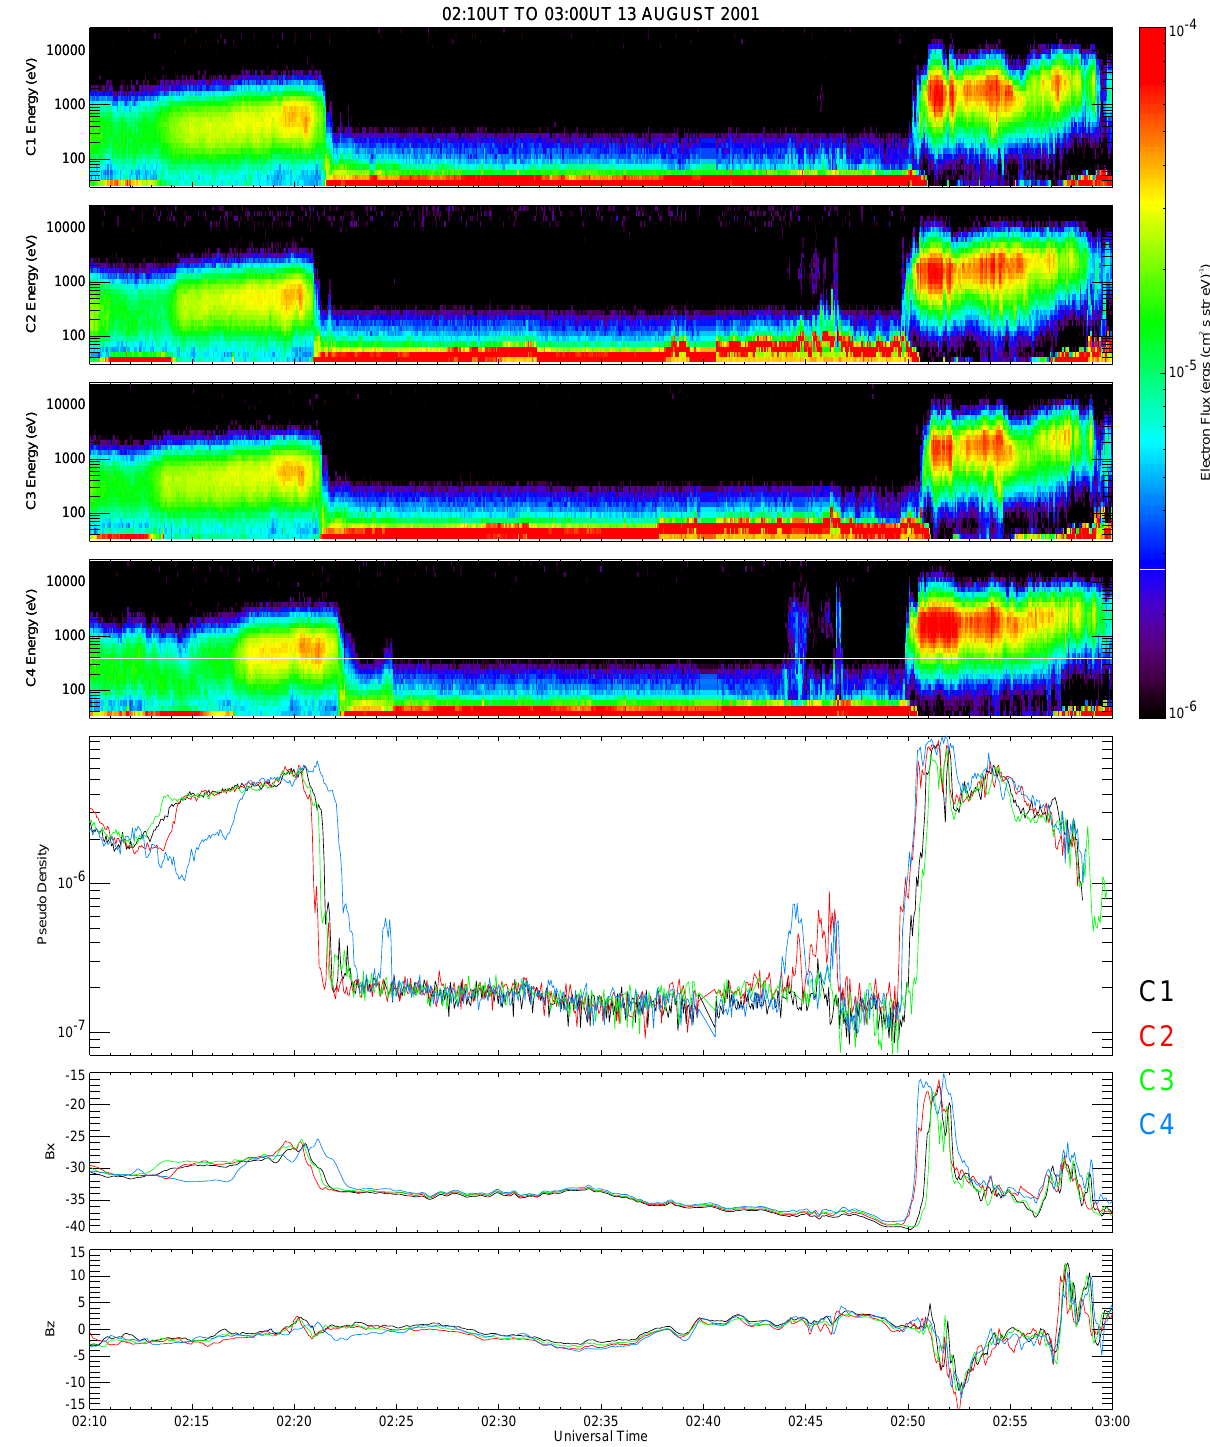
Fig. 5. Electron energy – differential flux spectrogram for C1 to C4 in the first four panels showing data summed over all pitch angles for the interval 02:10 UT to 03:00 UT on 13 August 2001. Plasma sheet plasma is punctuated by a period in the lobe. A density proxy (summed of all electrons above 135eV) is plotted in panel 5 using black, red, green and blue for C1 to C4, respectively. The B X and B Z components of the magnetic field measured at C3 are shown in panels 6 and 7. A clear magnetic field rearrangement is seen at C3 around the time of the plasma sheet passing over the spacecraft